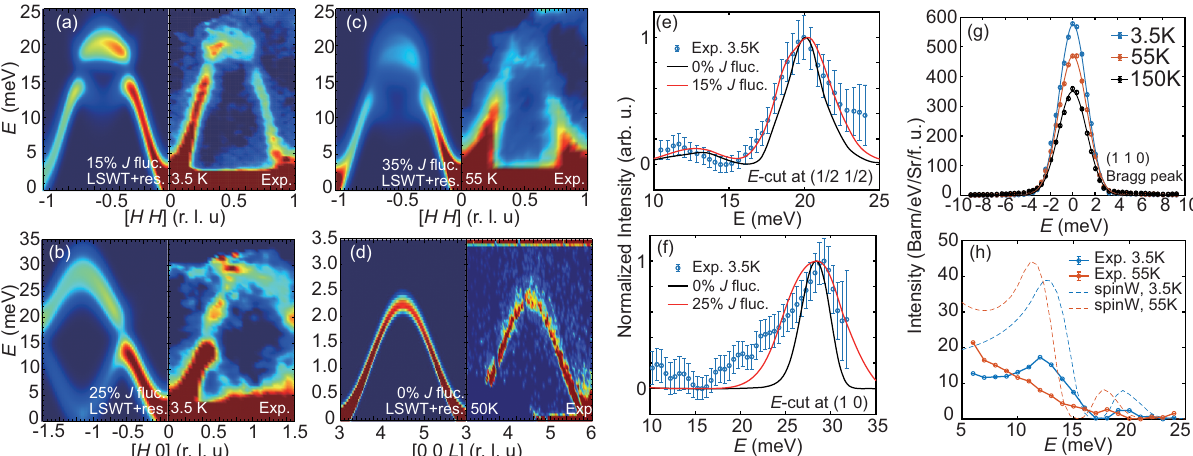
Fig. 4 Simulations on magnon spectrum broadening and the total moment sum rule. a LSWT calculations along the [ H , H ] direction with instrumental resolution, with 15% in-plane J fl uctuation compared with experimental results from SEQUOIA at 3.5 K; b LSWT calculation along the [ H , 0] direction with instrumental resolution, with 25% in-plane J fl uctuation, compared with experimental results; c same calculation as in a with 35% in-plane J fl uctuation and experimental results at 55 K; d The [0, 0, L ] dispersion at 50 K, with no fl uctuation of J in the calculation. e , f Respective E -cuts at the M point and Γ point for the experimental data (blue dots), calculation without J fl uctuation (black lines) and with J fl uctuation (red lines). g The (1, 1, 0) elastic peak at 3.5, 55, and 150 K, normalized to absolute units; h The INS intensity S ( E ) at 3.5 K and 55 K, averaged over the fi rst Brillouin zone. The dashed lines are calculations of spin-wave intensities from the LSWT. The vertical error bars in e and f represent statistical errors of 1 standard